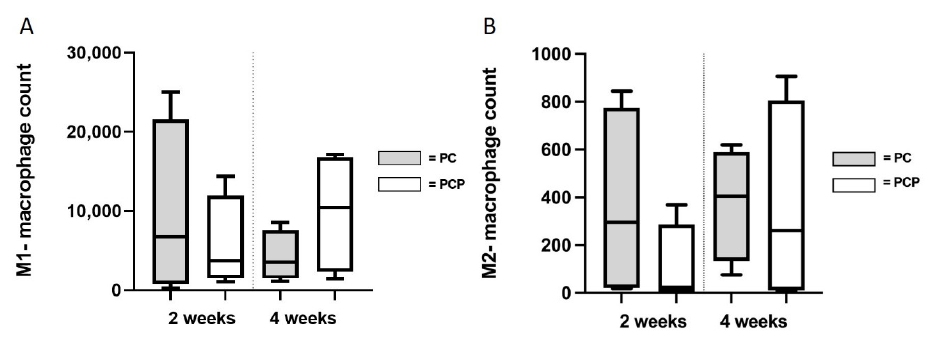
Figure 7. Count of pro- (M1) ( A ) and anti-inflammatory (M2) ( B ) macrophages. No differences in the immunological interaction of PCL-collagen I-scaffolds or PCL-collagen I-PEO-scaffolds were found after two weeks or four weeks.